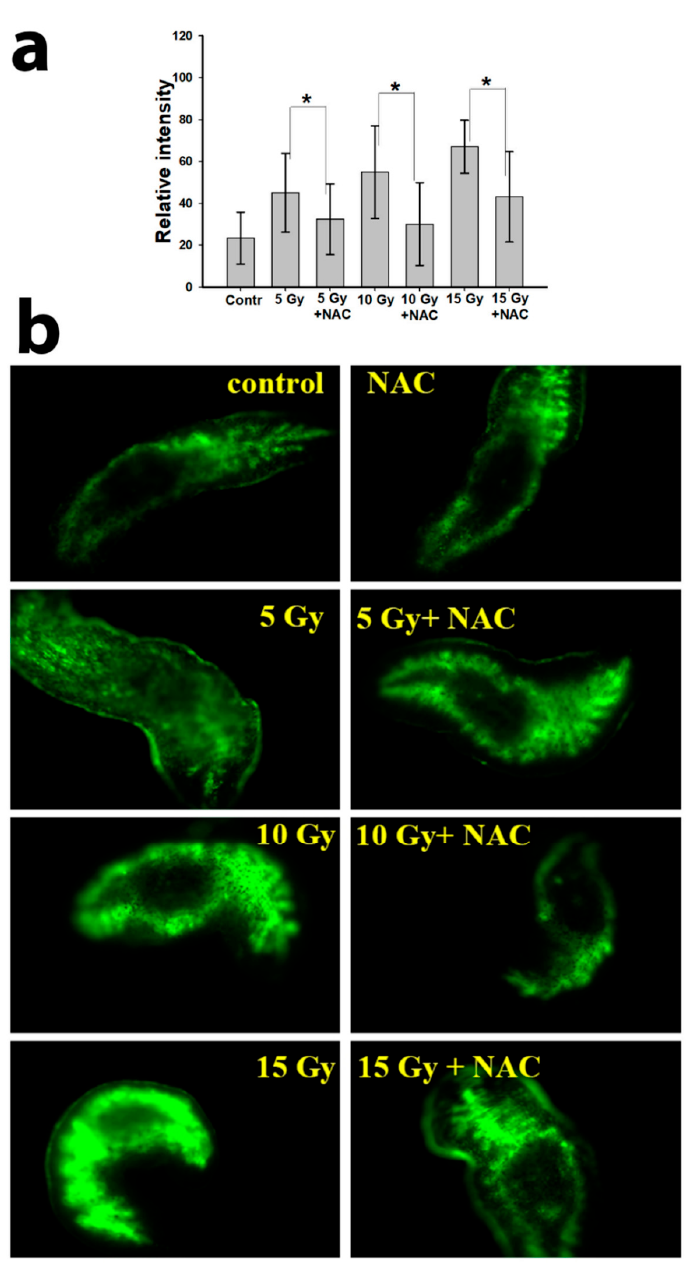
Figure 6. Inhibition of ROS formation by N-acetylcysteine, measured by H2DCFDA fluorescence. Quantitative determination of the fluorescence intensity in the body of planarians ( a ); fluorescence micrographs of planarians after irradiation ( b ). Standard deviation * p < 0.001.